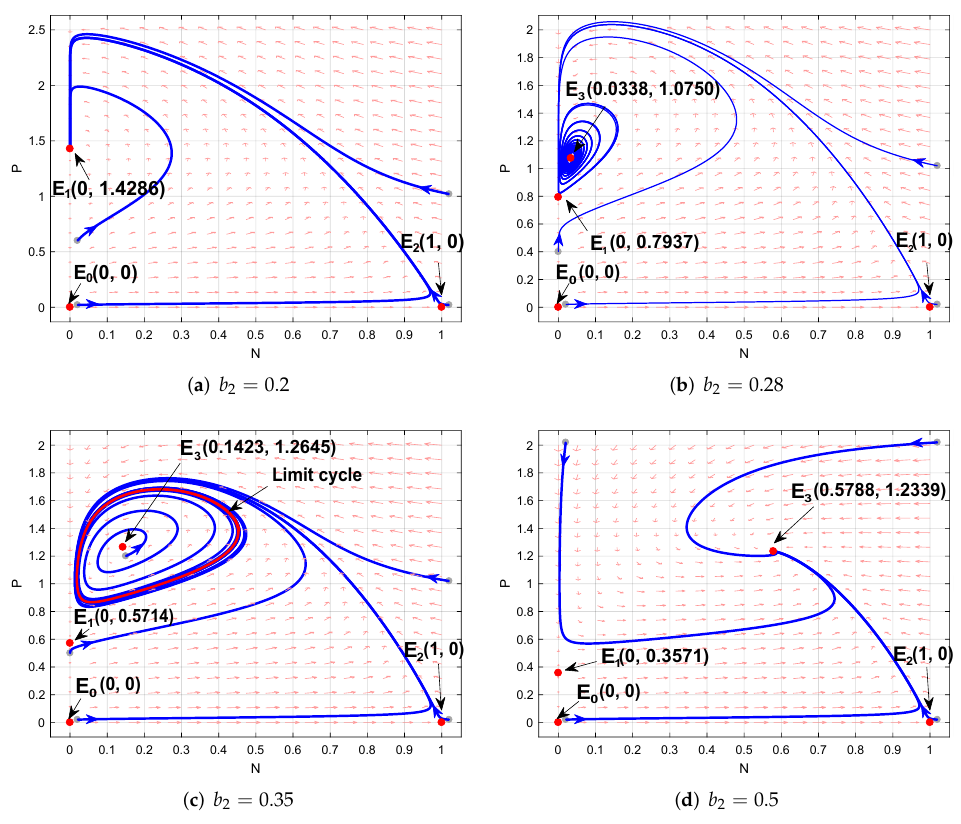
Figure 6. Phase Portraits of the system (3) with parameter values as in Table 3 and ( a ) b 2 = 0.2, ( b ) b 2 = 0.28, ( c ) b 2 = 0.35, and ( d ) b 2 = 0.5. Table 4. Values of parameter to see the impacts of predator refuge.